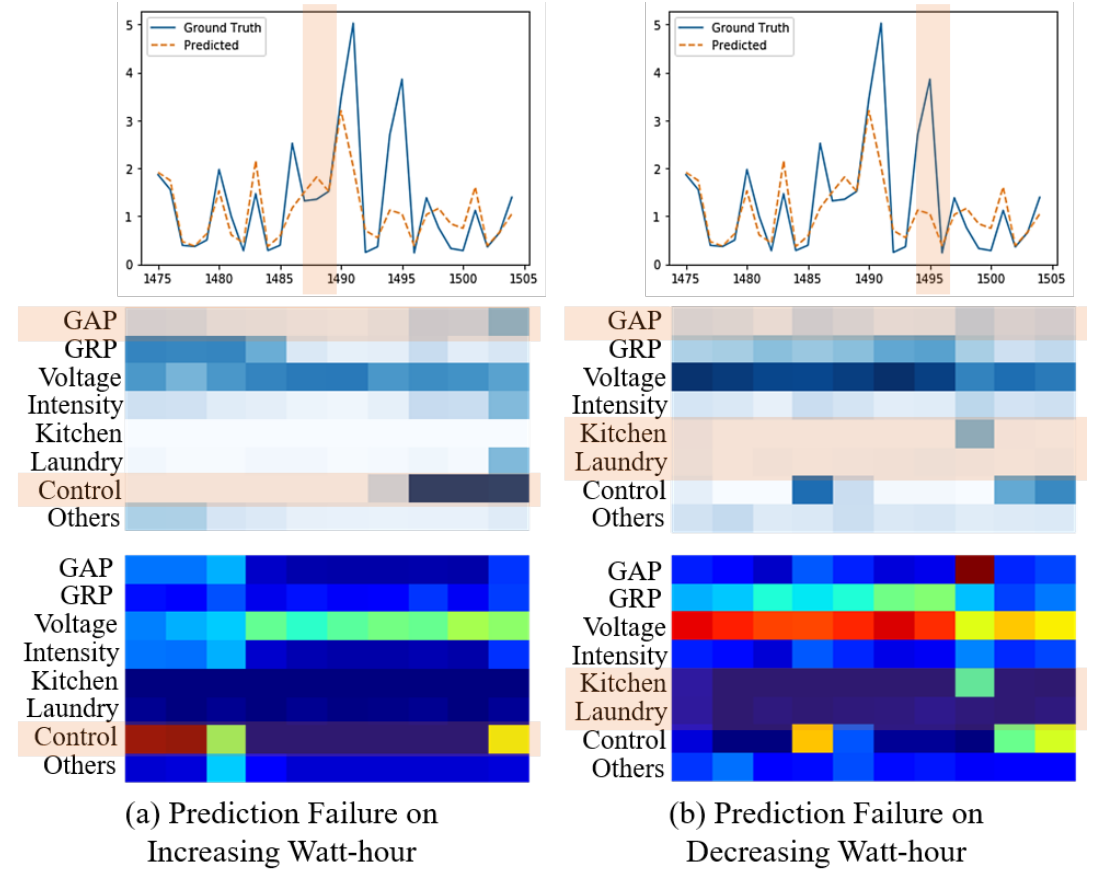
Figure 9. The gradients in the convolutional layers depicted by class activation map.